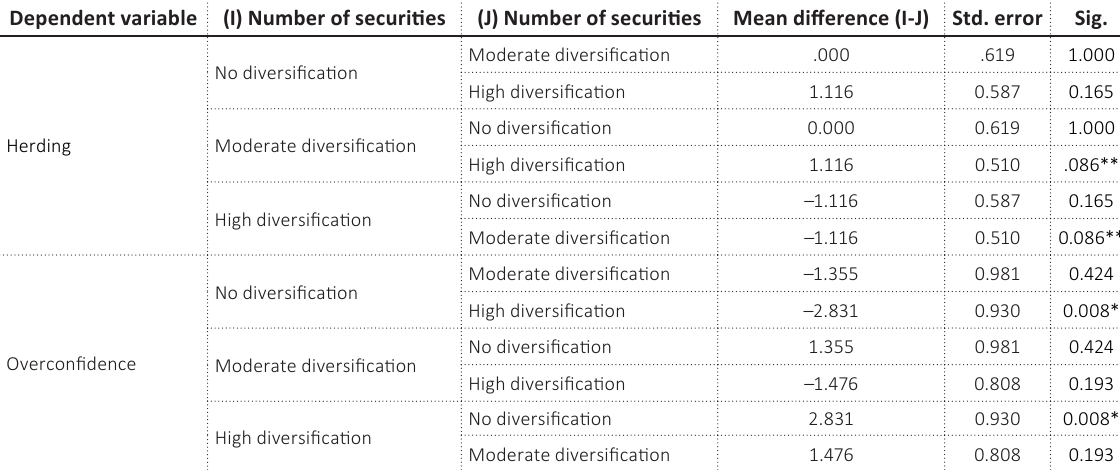
Table 6. Post hoc analysis (multiple comparisons: